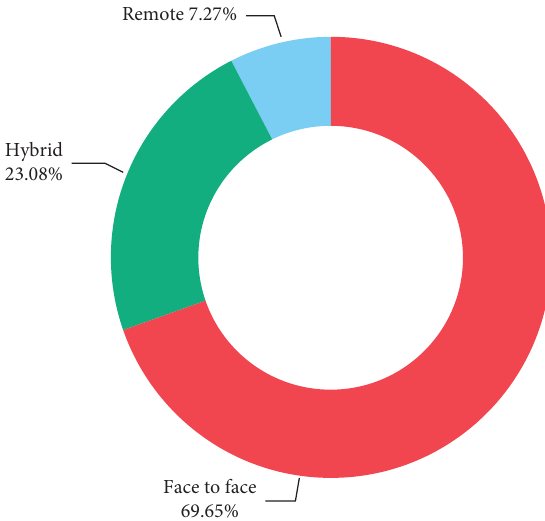
Figure 12: Preferred type of